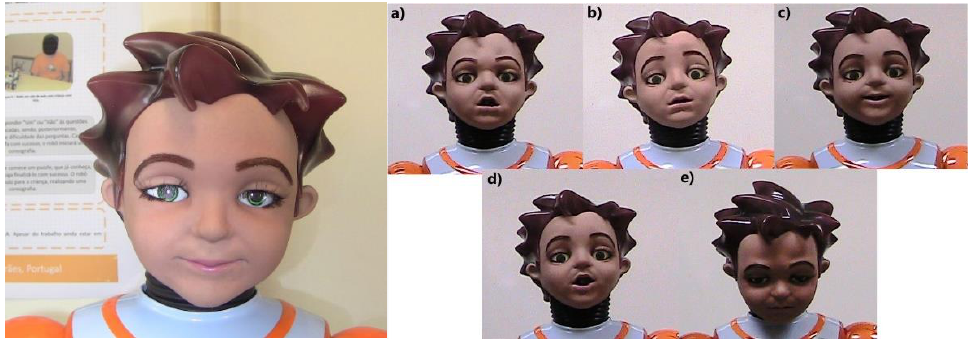
Figure 2. On the left: ZECA, a Zeno R50 RoboKind® humanoid robot. On the right: Facial expressions displayed by ZECA: ( a ) anger; ( b ) fear; ( c ) happiness; ( d ) surprise; ( e ) sadness [9].